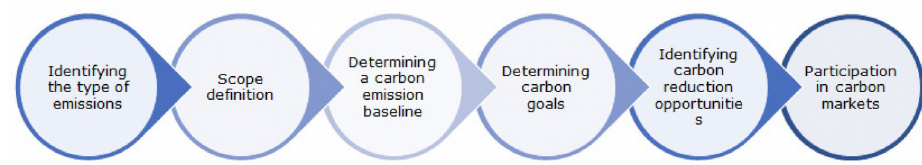
Figure 2. The six steps of the Green Supply Chain Strategy (Based on GHG